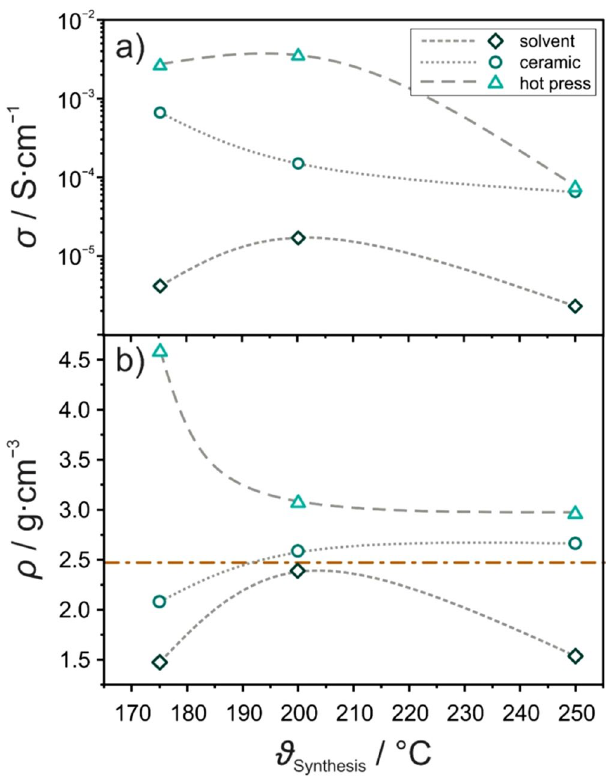
Figure 3. ( a ) Room-temperature conductivities of Li 4 PS 4 I prepared by wet-chemical, solid-state or hot-press synthesis at different temperatures of 175, 200 and 250 °C and ( b ) corresponding experimental densities. Note that the gray dotted/dashed lines are for eye guidance only. The brown line indicates the crystallographic density of tetragonal